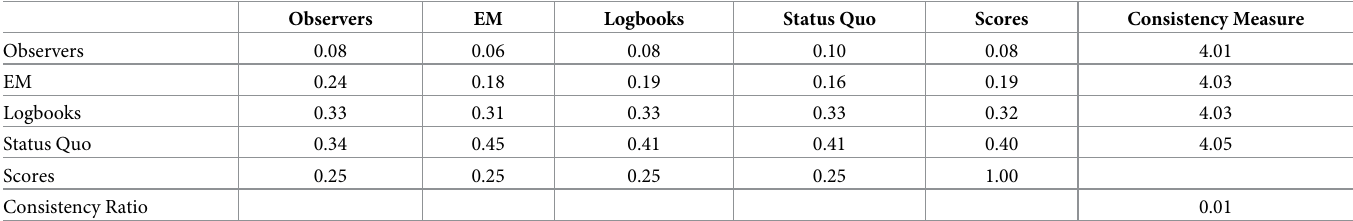
Table 3. AHP using the geometric mean, across pairwise comparisons of human observers (‘Observers’), electronic monitoring (‘EM’), detailed logbooks (‘Log- books’), and the status quo (‘Status Quo’) alternatives for data collection at sea. Observers